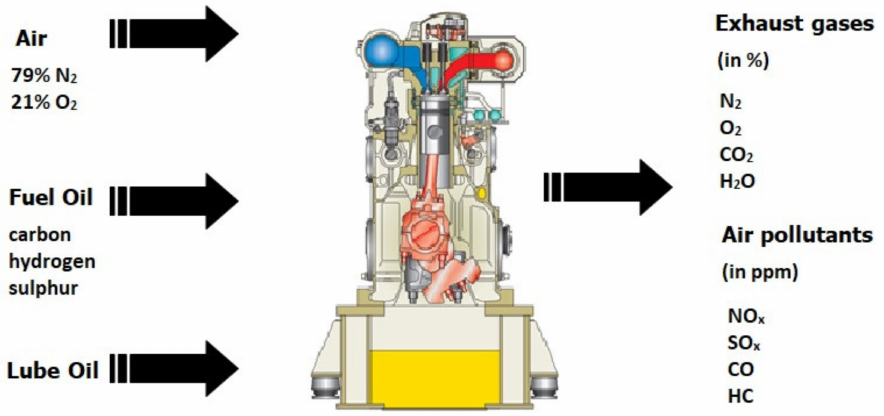
Figure 1. Combustion process in